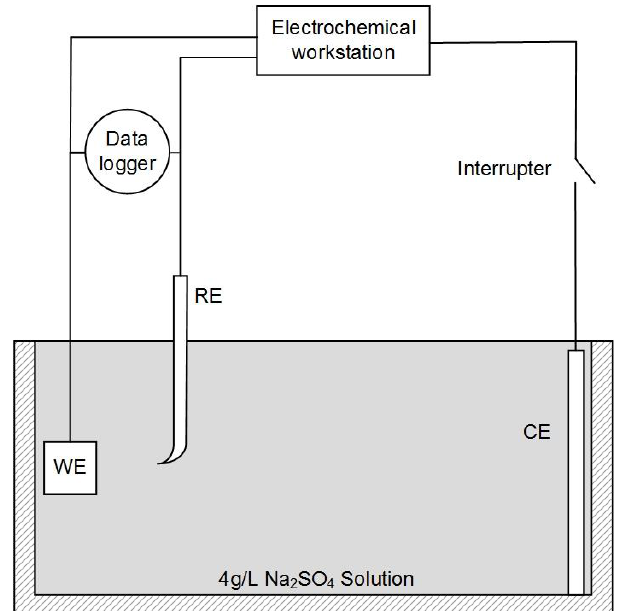
Figure 1. Schematic diagram of the electrochemical test circuit combined with the current interrupt method.